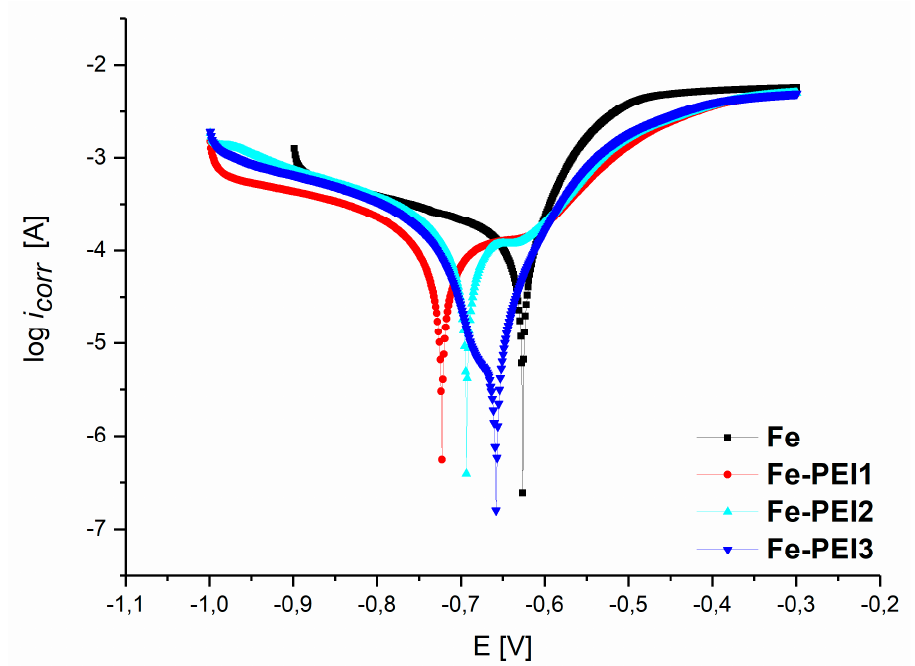
Figure 6. Polarization curves of the iron-based foams with or without PEI coating obtained in the Hanks’ solution at 37 ± 1 °C.